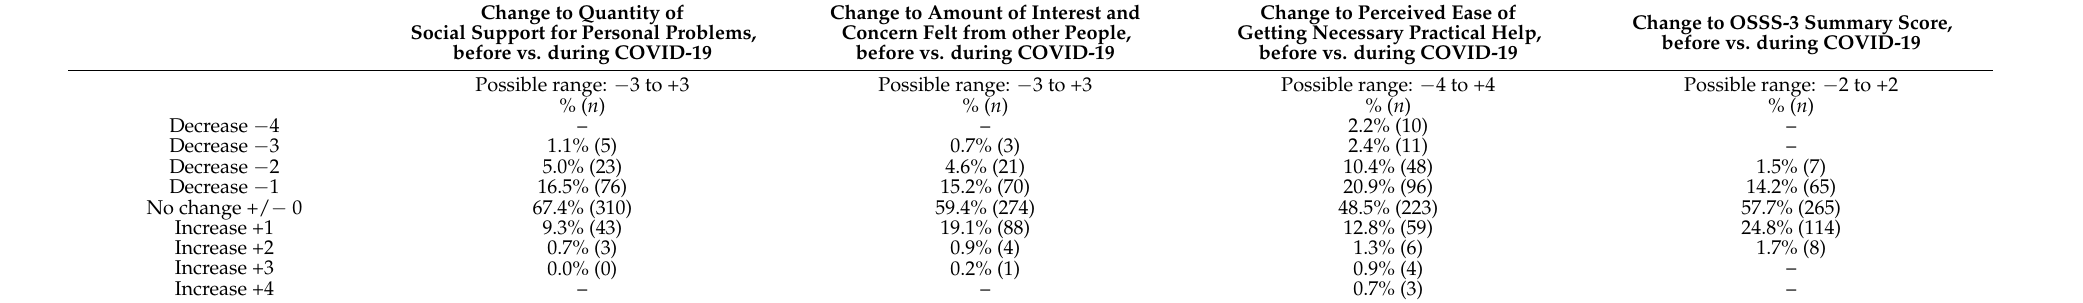
Table 2. Distribution of change scores for social support from before to during the COVID-19 pandemic by social support ( n = 461). Change to Quantity of Change to Amount of Interest and Change to Perceived Ease of Change to OSSS-3 Summary Score, Social Support for Personal Problems, Concern Felt from other People, Getting Necessary Practical Help, before vs. during COVID-19 before vs. during COVID-19 before vs. during COVID-19 before vs. during COVID-19 Possible range: − 3 to +3 Possible range: − 3 to +3 Possible range: − 4 to +4 Possible range: − 2 to +2 % ( n